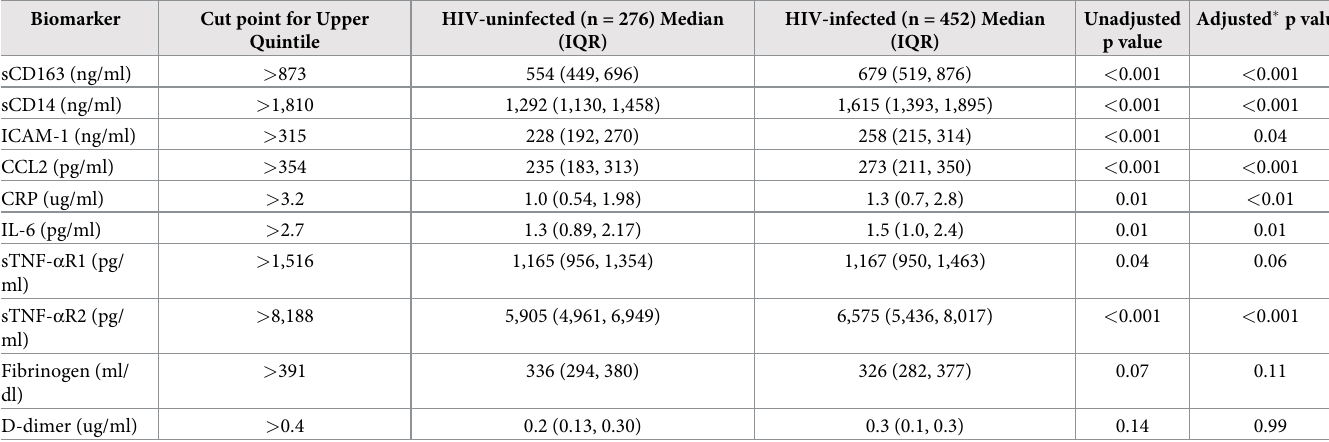
Table 2. Levels of inflammatory biomarkers, by HIV